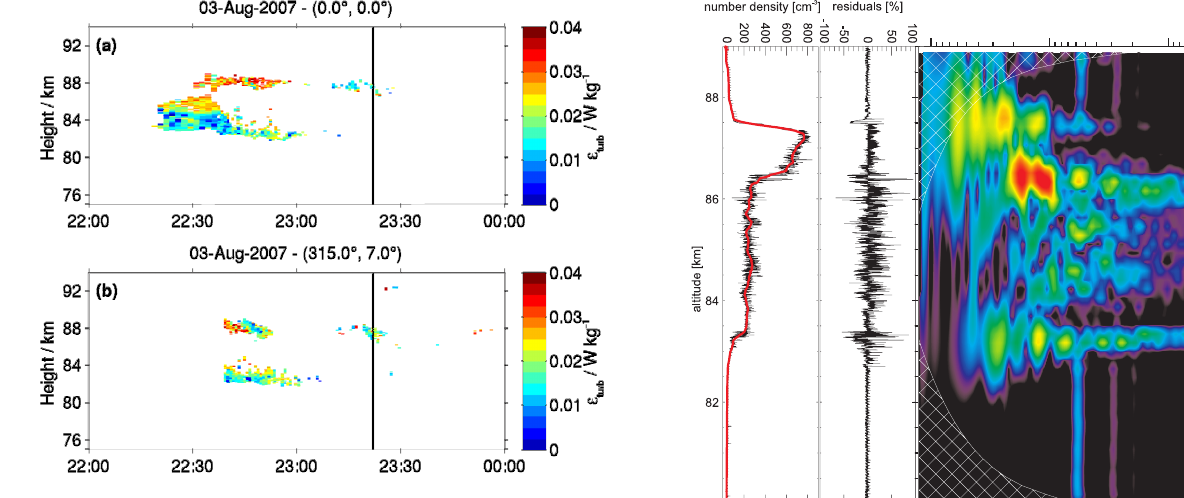
Fig. 3. Turbulence energy dissipation rates, ε , derived from ALWIN radar measurements during ECOMA/MASS salvo. Upper panel shows results from the vertical beam and the lower panel from the 7 ◦ NW-tilted beam. Vertical black line marks time of the ECOMA launch at 23:22:00UT.